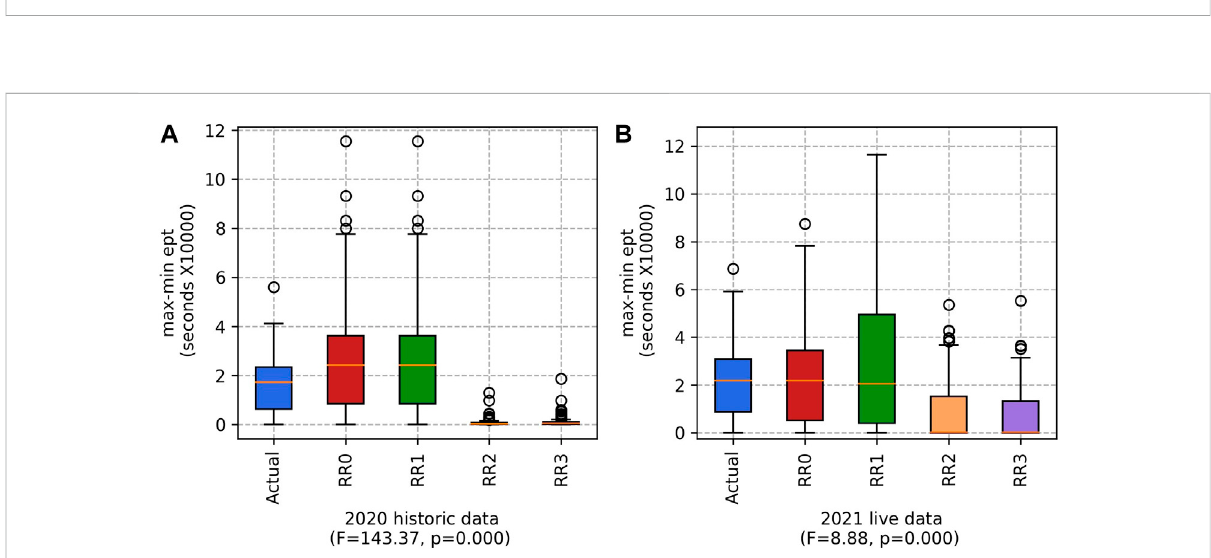
FIGURE 6 The max-min ept for the (A) 2020 historic and (B) 2021 live datasets. (Lower values are